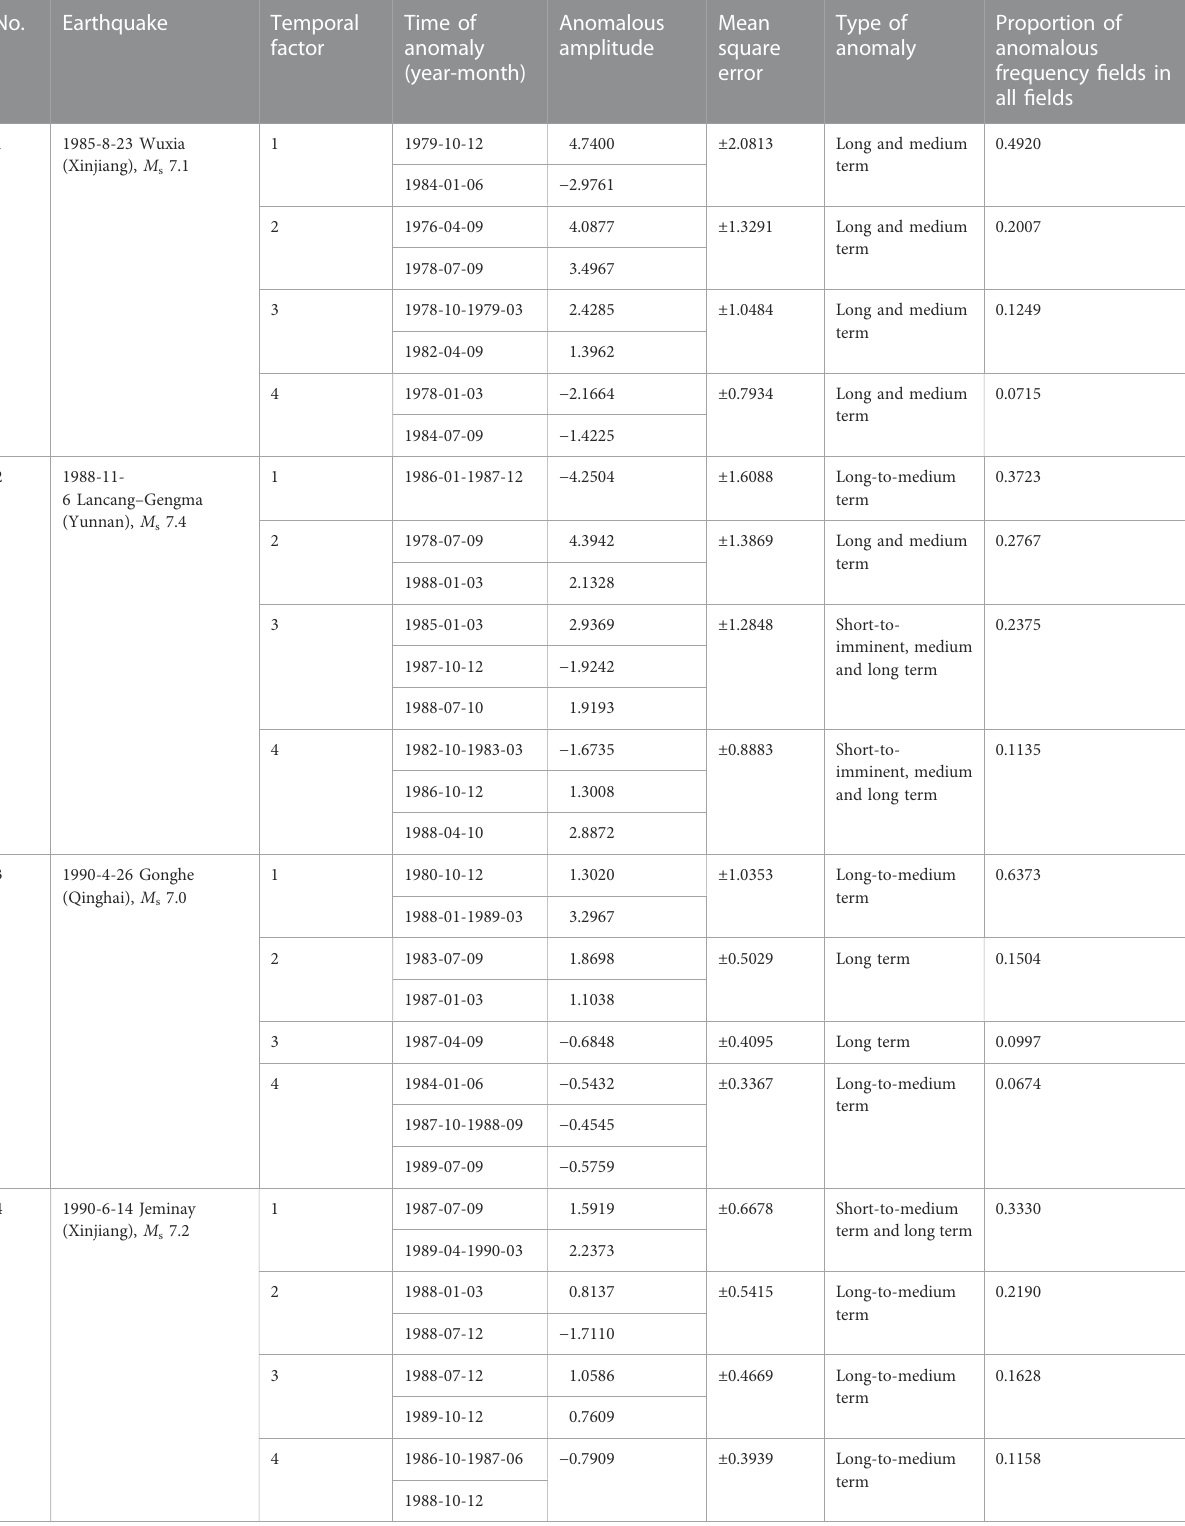
Anomalous amplitude